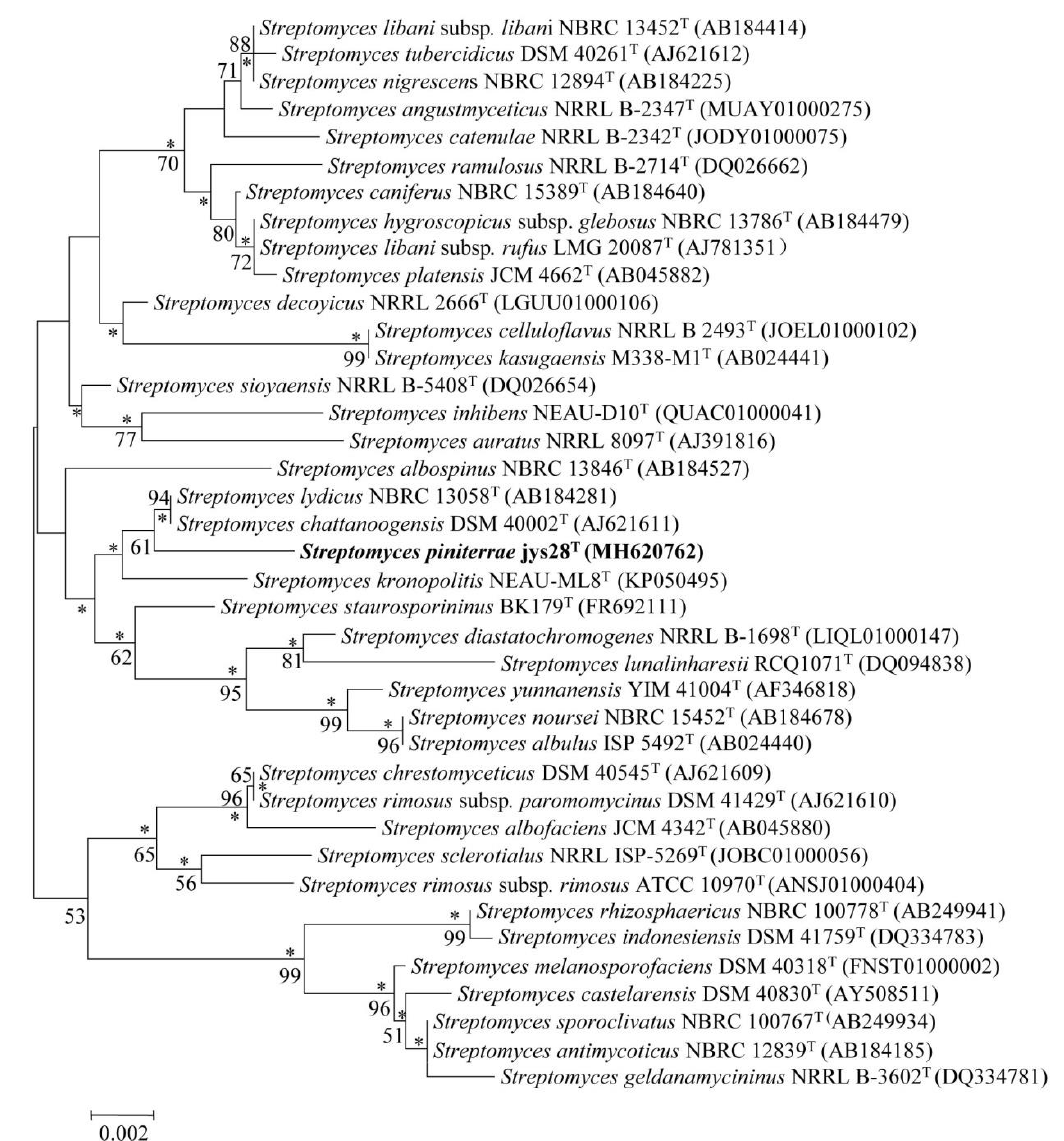
Figure 1. Neighbour-joining tree showing the phylogenetic position of strain jys28 T and related taxa based on 16S rRNA gene sequences. Asterisks indicate branches that were also found using the maximum-likelihood method. Numbers at branch points indicate bootstrap percentages (based on 1000 replicates); only values > 50% are indicated. Bar, 0.002 substitutions per nucleotide position.